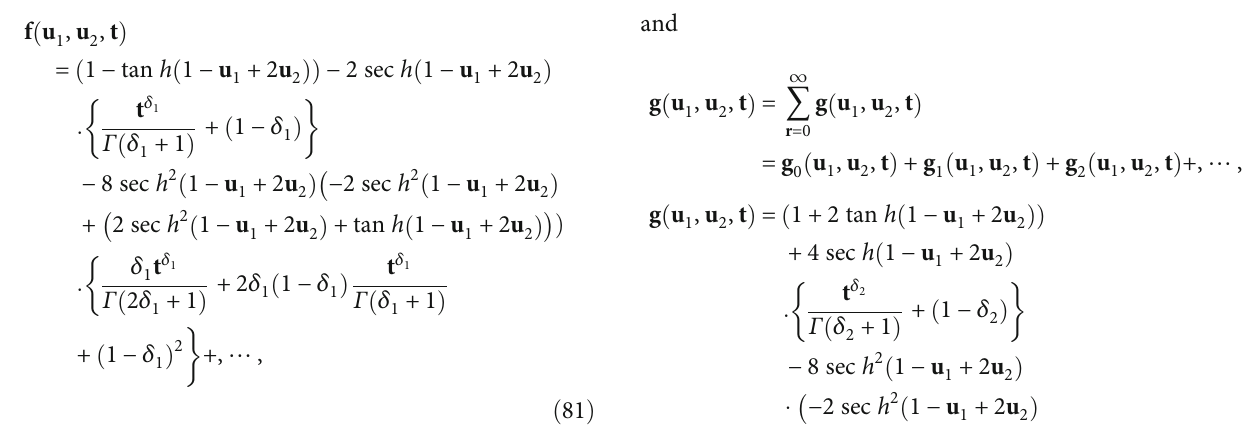
Figure 4: (a) 3D view of absolute error for g ð u when t = 0 : 7 :